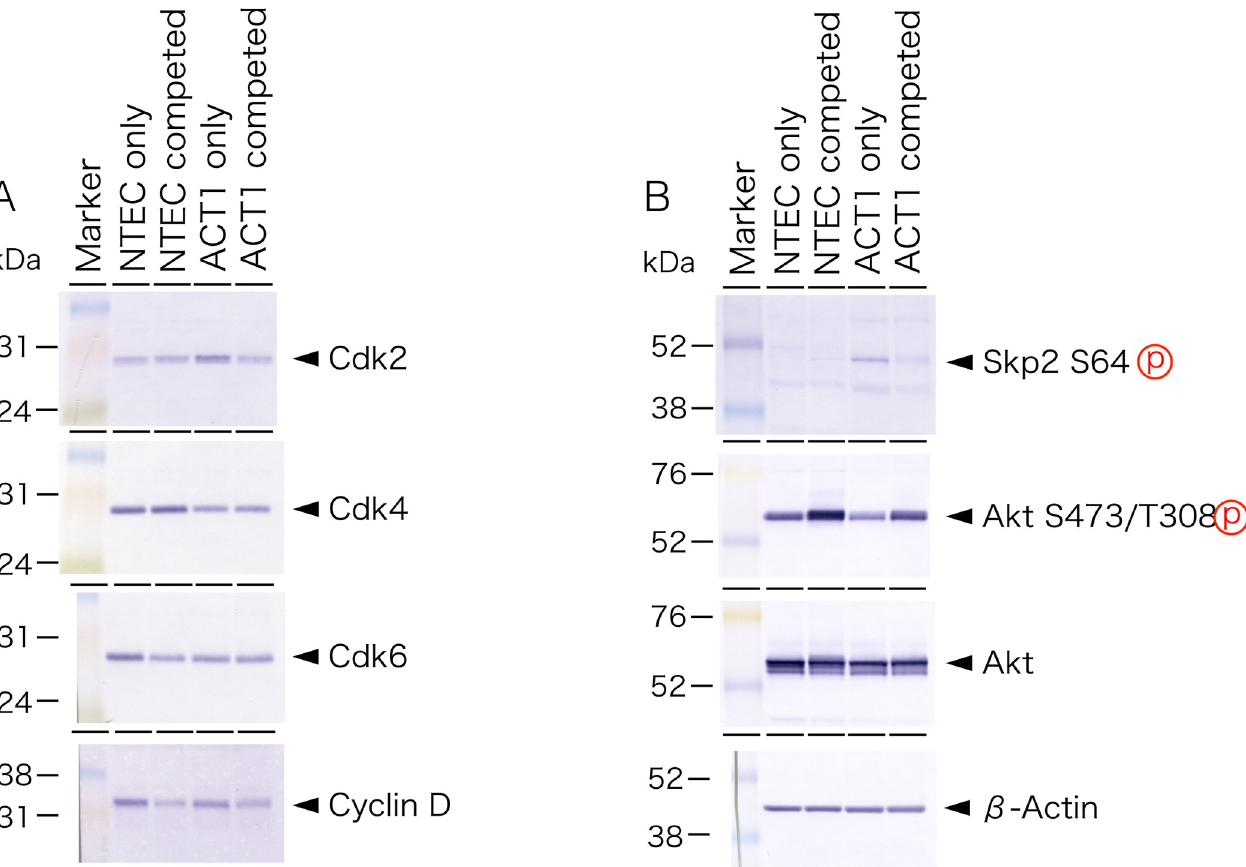
Fig 8. Western blot analysis of cell cycle regulators and Akt. Total protein was extracted from both NTECs and ACT1 cells cultured either alone (NTEC or ACT1 only, respectively) or from cell co-cultures (NTEC or ACT1 competed, respectively) and subjected to western blot analysis with indicated antibodies.